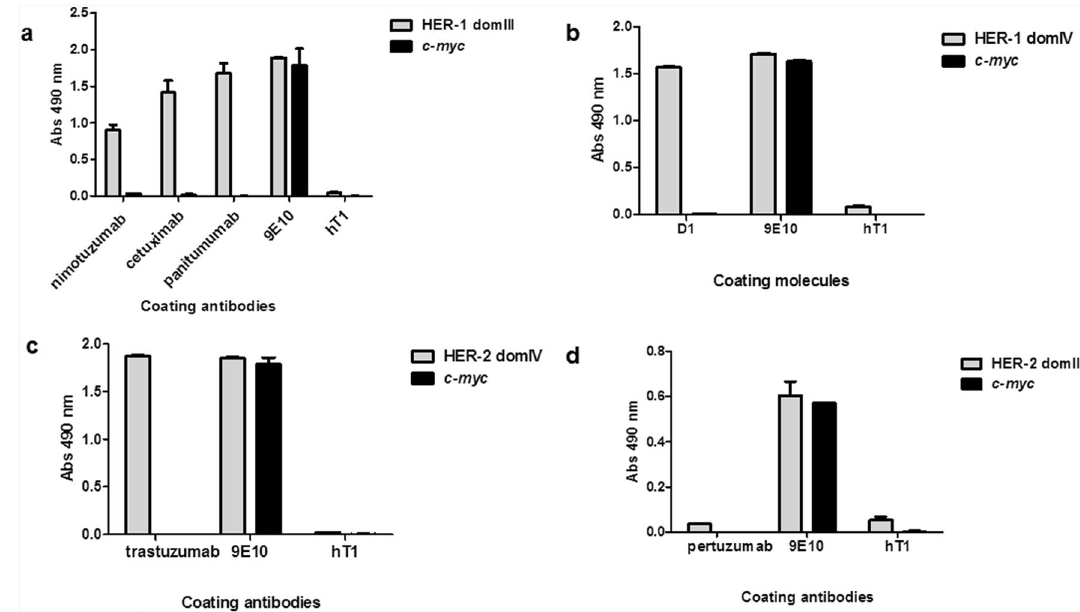
Figure 2. Recognition of phage-displayed domains of HER-1 and HER-2 by monoclonal antibodies in ELISA. Purified phages were incubated on polyvinyl chloride microtiter plates coated with monoclonal antibodies. Bound phages were detected with anti-M13 antibody conjugated to horseradish peroxidase. Humanized T1 antibody (hT1) was used as unrelated coating antibody to assess specificity. Coating 9E10 mAb recognizing all c-myc tagged proteins was used as positive control. Phages displaying c-myc only were also evaluated. Recognition of phage-displayed HER-1 domain III by nimotuzumab, cetuximab and panitumumab ( a ).